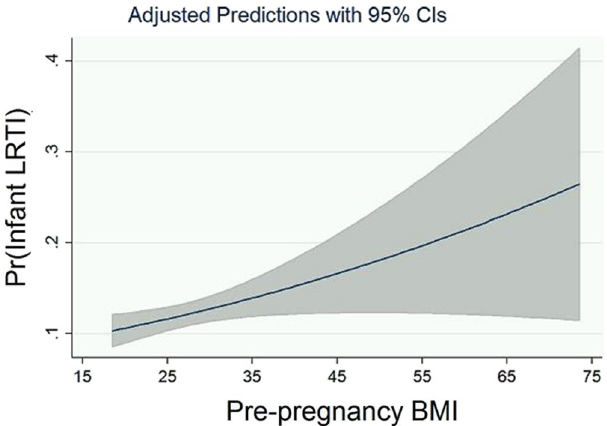
Figure 2. The predicted probability of LRTI during infancy increases with maternal pre-pregnancy BMI. Margins plot showing the increase in the predicted probability of LRTI during infancy (Pr(Infant LRTI)) from